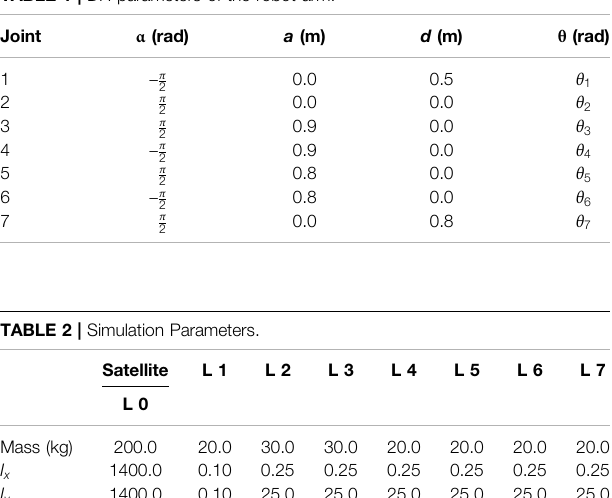
TABLE 1 | DH parameters of the robot